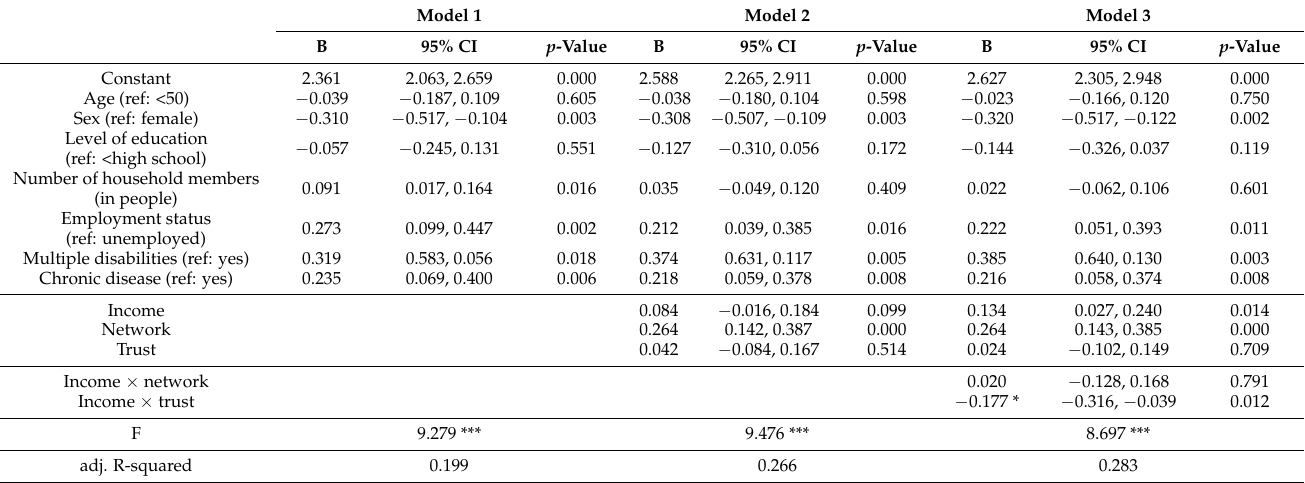
Table 4. Hierarchical regression analysis and moderating effect analysis